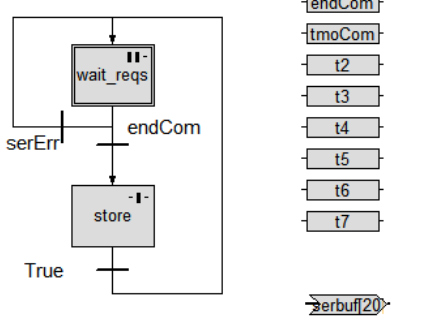
Figure 11. Example of use of the Packet Communication primitive.